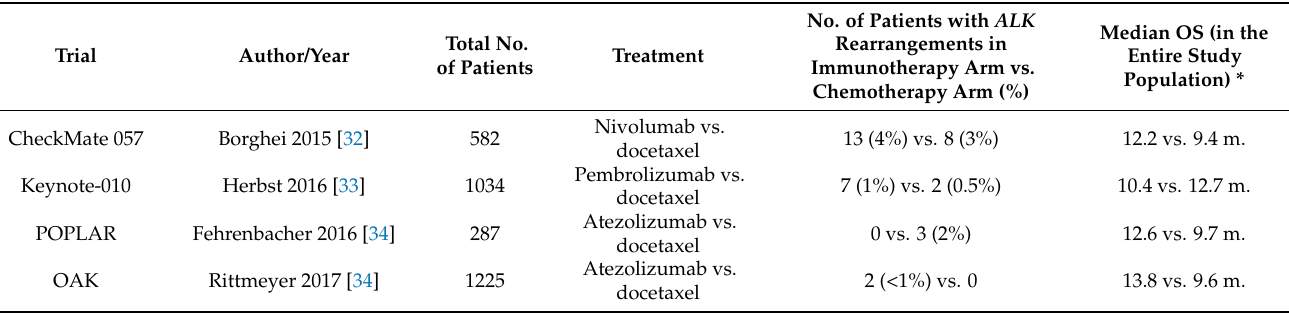
Table 2. Prospective clinical trials evaluating immune checkpoint inhibitors in advanced non-small cell lung cancer patients which included patients with ALK -rearranged non-small cell lung